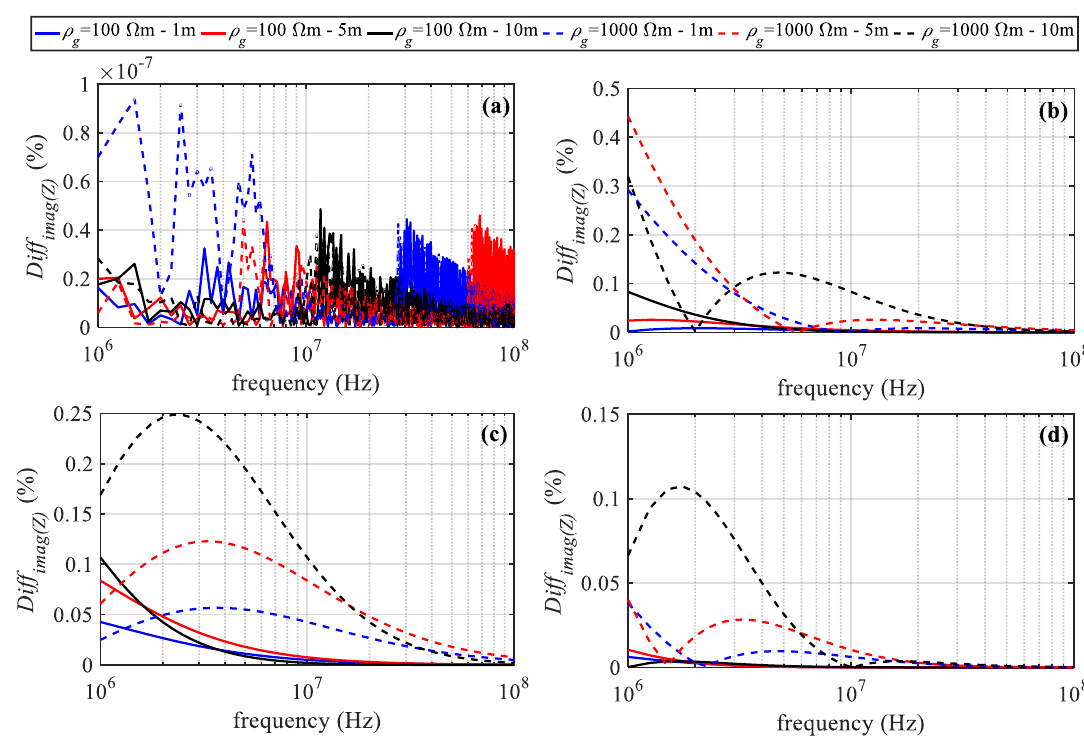
Figure 12. Differences in the imaginary part of Z 13 in BB using the closed-form expression of ( a ) Carson, ( b ) Dubanton ( c ) Noda and ( d ) Alvarado-Betancourt.